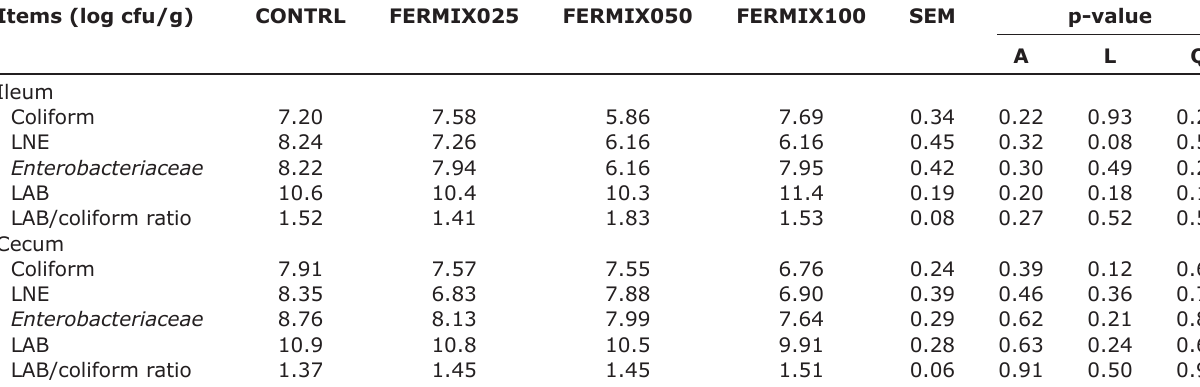
Table-6: Selected intestinal bacterial population of broiler chickens. Items (log cfu/g)